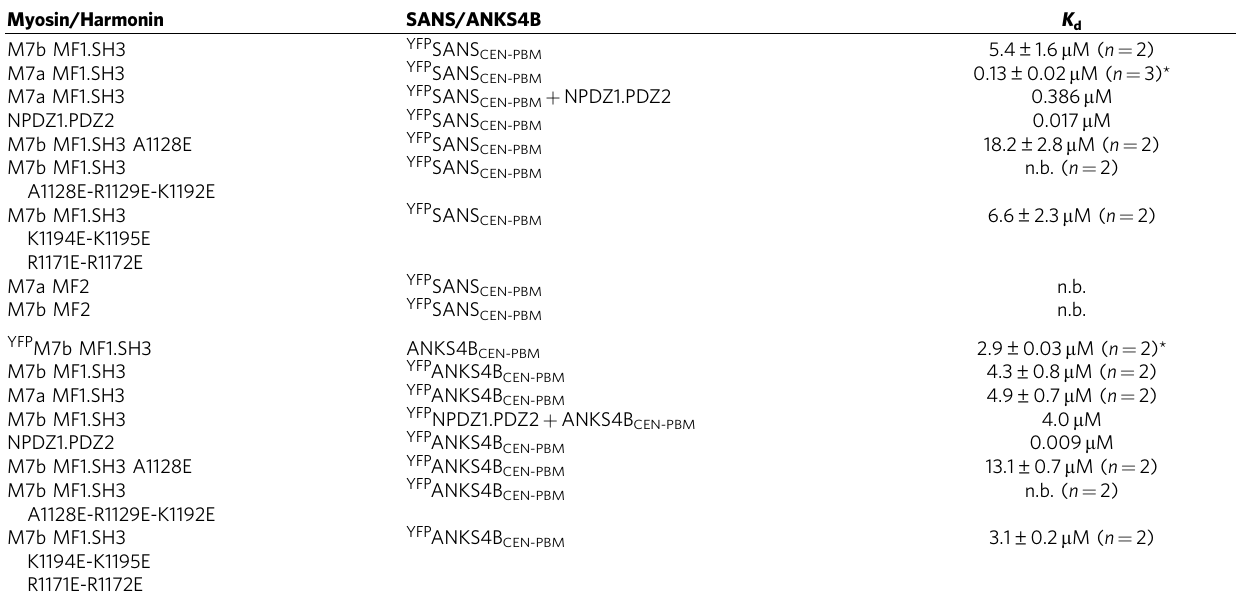
Table 4 | Myo7 MF1.SH3 interaction with SANS or